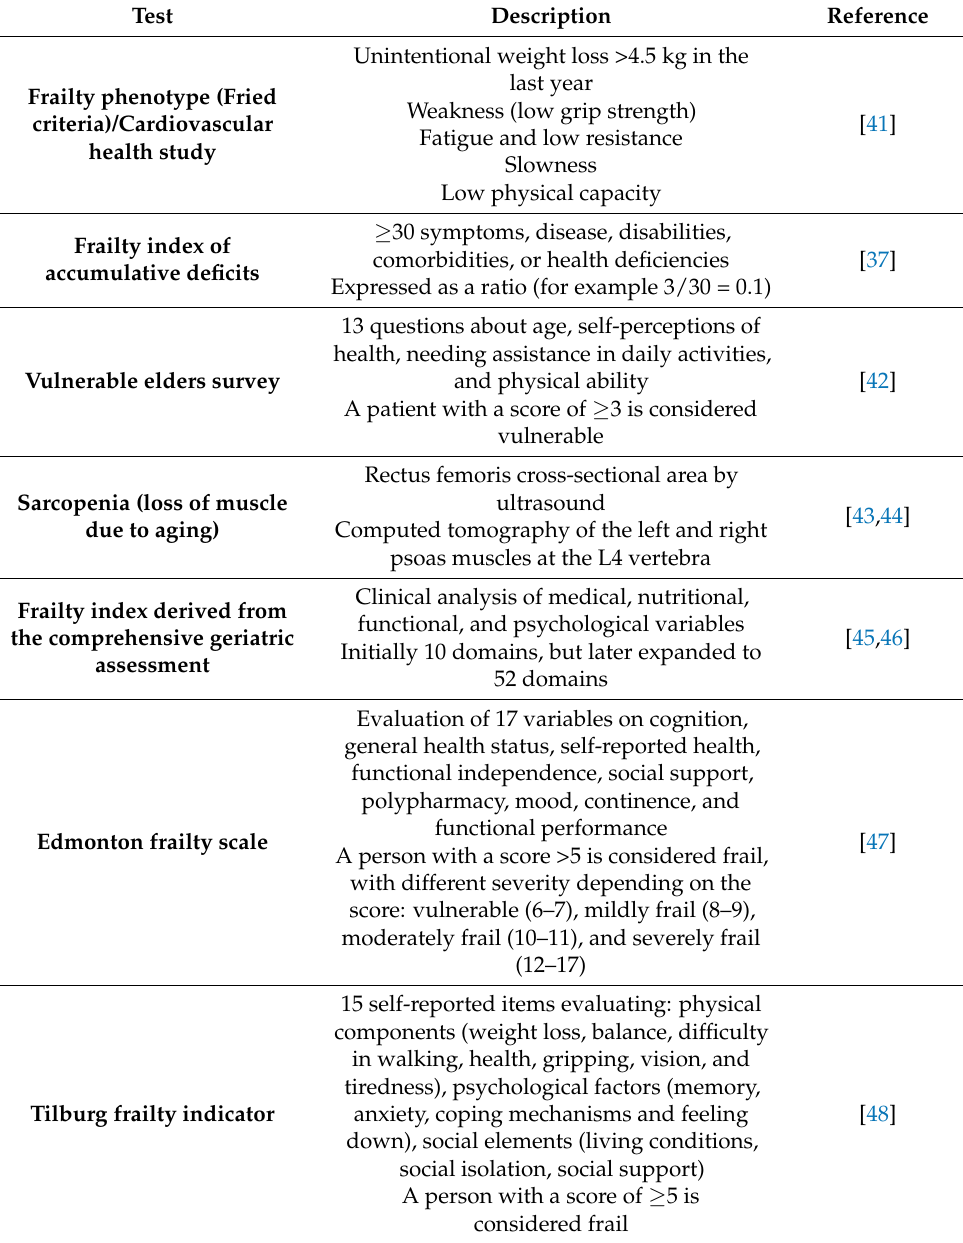
Table 1. Frailty measurement